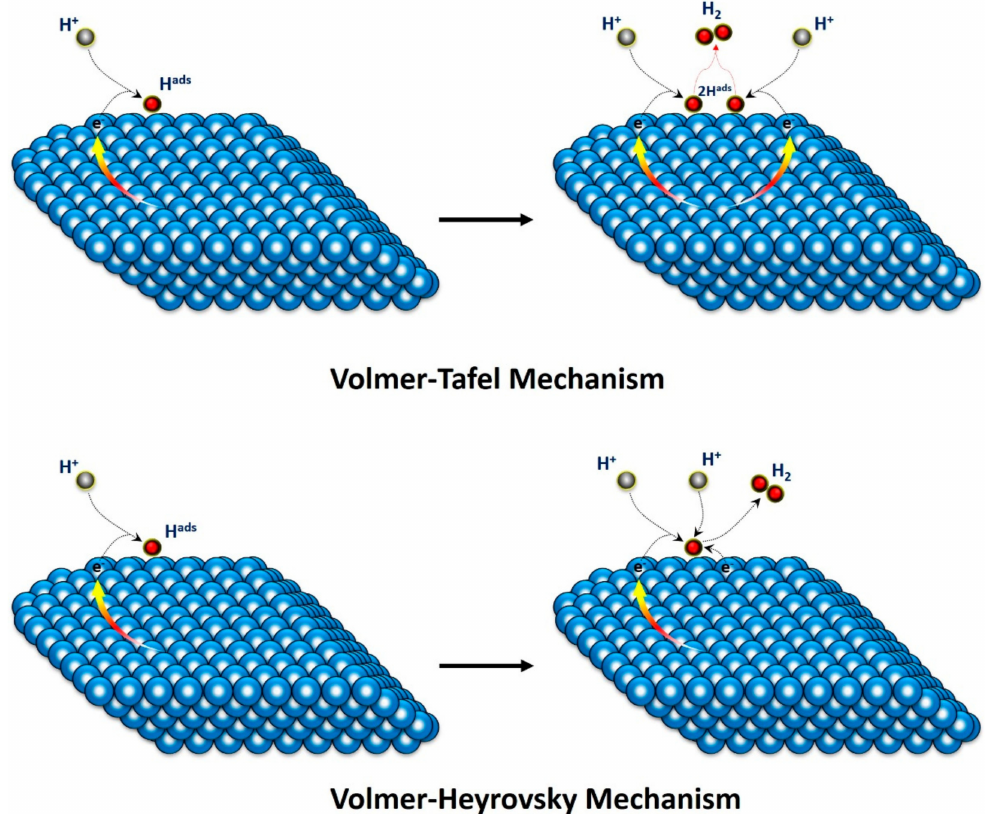
Figure 1. The hydrogen evolution reaction (HER) pathways on the catalyst